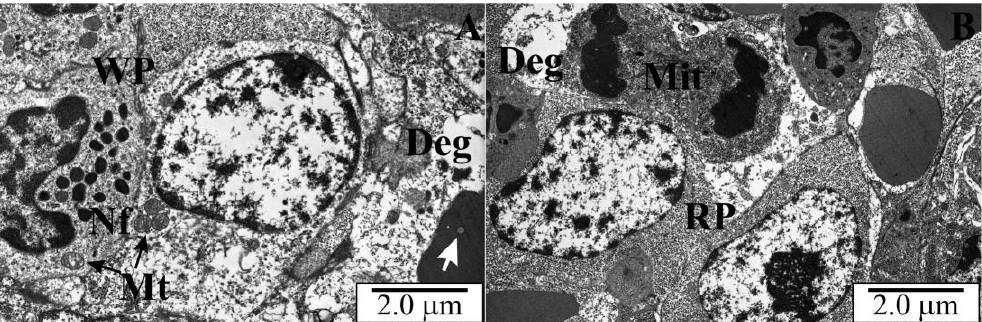
Figure 11. ( A , B ) Ultrathin sections across spleens of intrauterine rats infected with B. microti . Deg—degenerating zones, Mit—cells during karyokinesis, Mt—mitochondria, Nf—neutrophil, RP—red pulp, WP—white pulp, white arrows— B. microti merozoites.